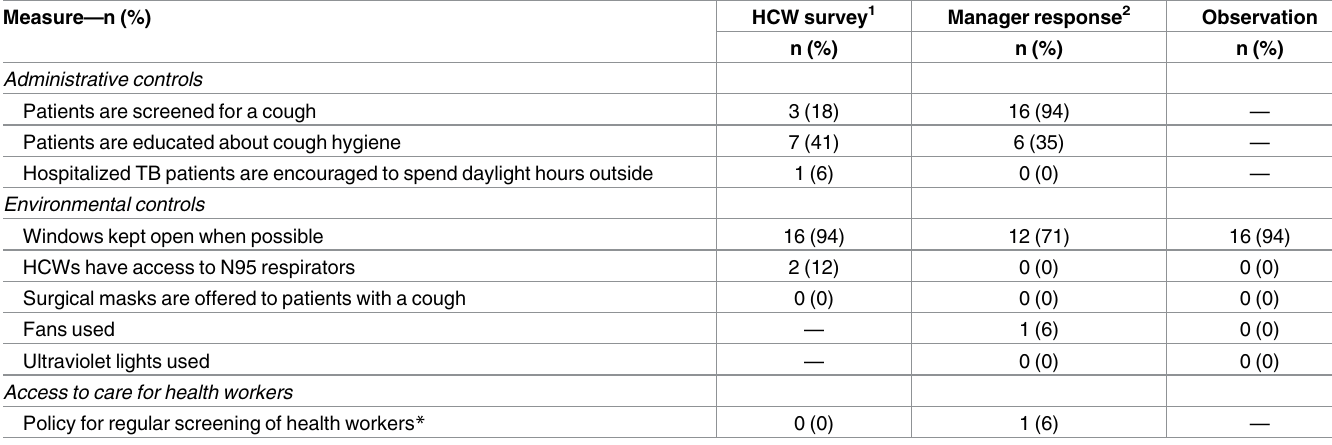
Table 4. Number of facilities implementing IPC guidelines according to data source (N =